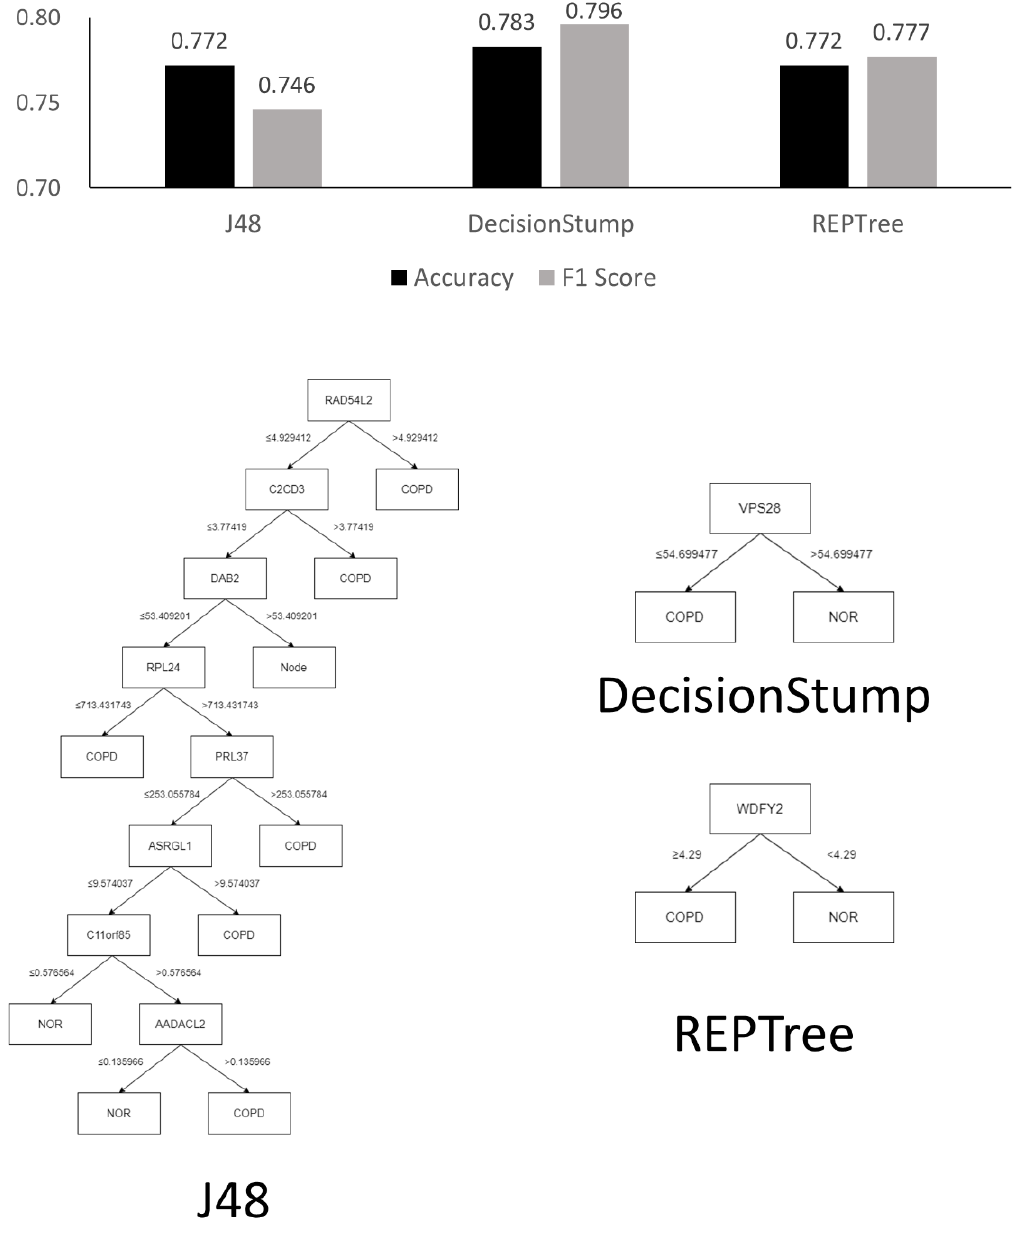
Figure 6. Chart for visualizing the performance of the three decision tree models with the GSE57148 dataset [30] and their structure.